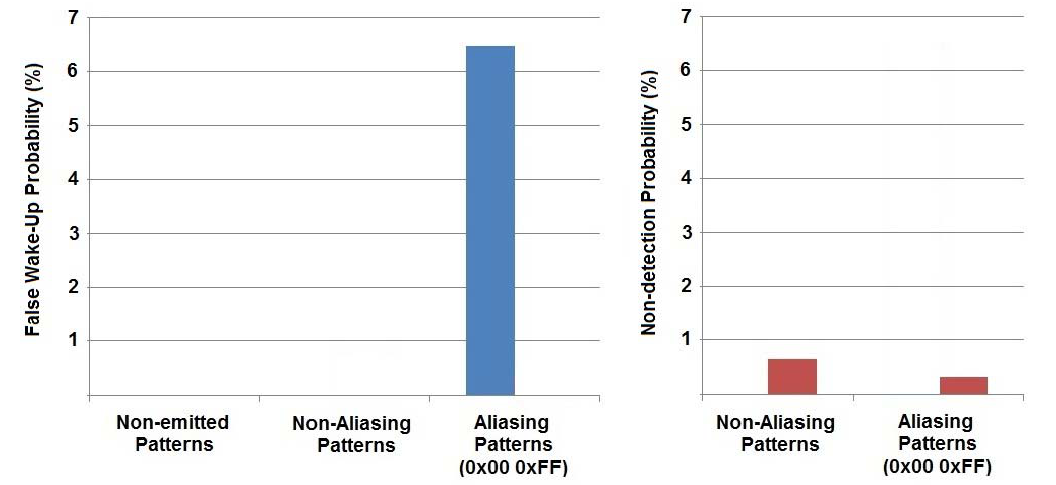
Figure 11. Results obtained emitting different patterns (0x00, 0x7F, 0x55, 0X0F,